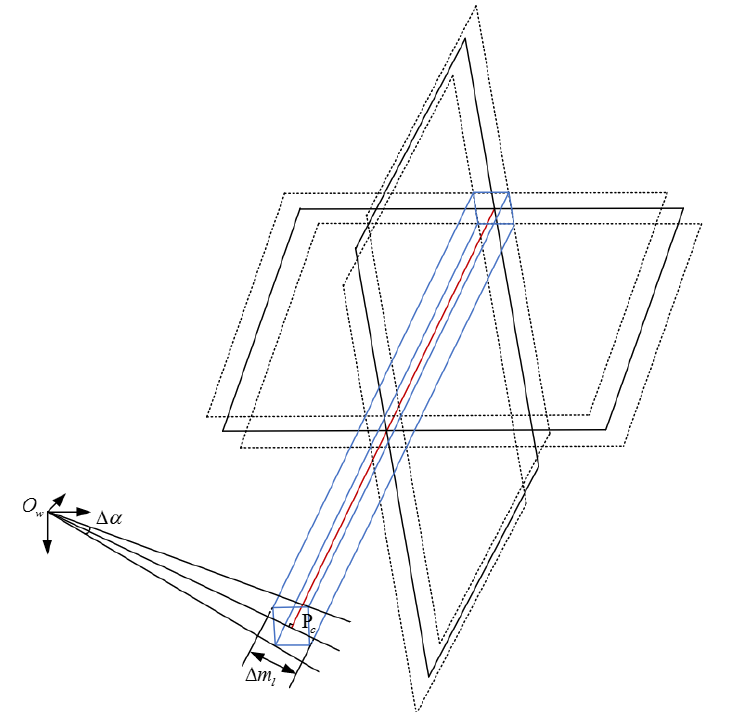
Figure 6. Uncertainty of line reconstruction with fixed direction by triangulation. The cylinder region illustrates the uncertainty region, which depends on the biases of the planes and the angle between the